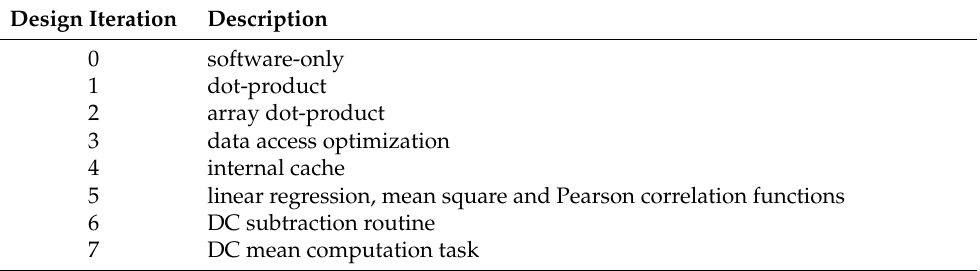
Table 1. Main improvement added on each design